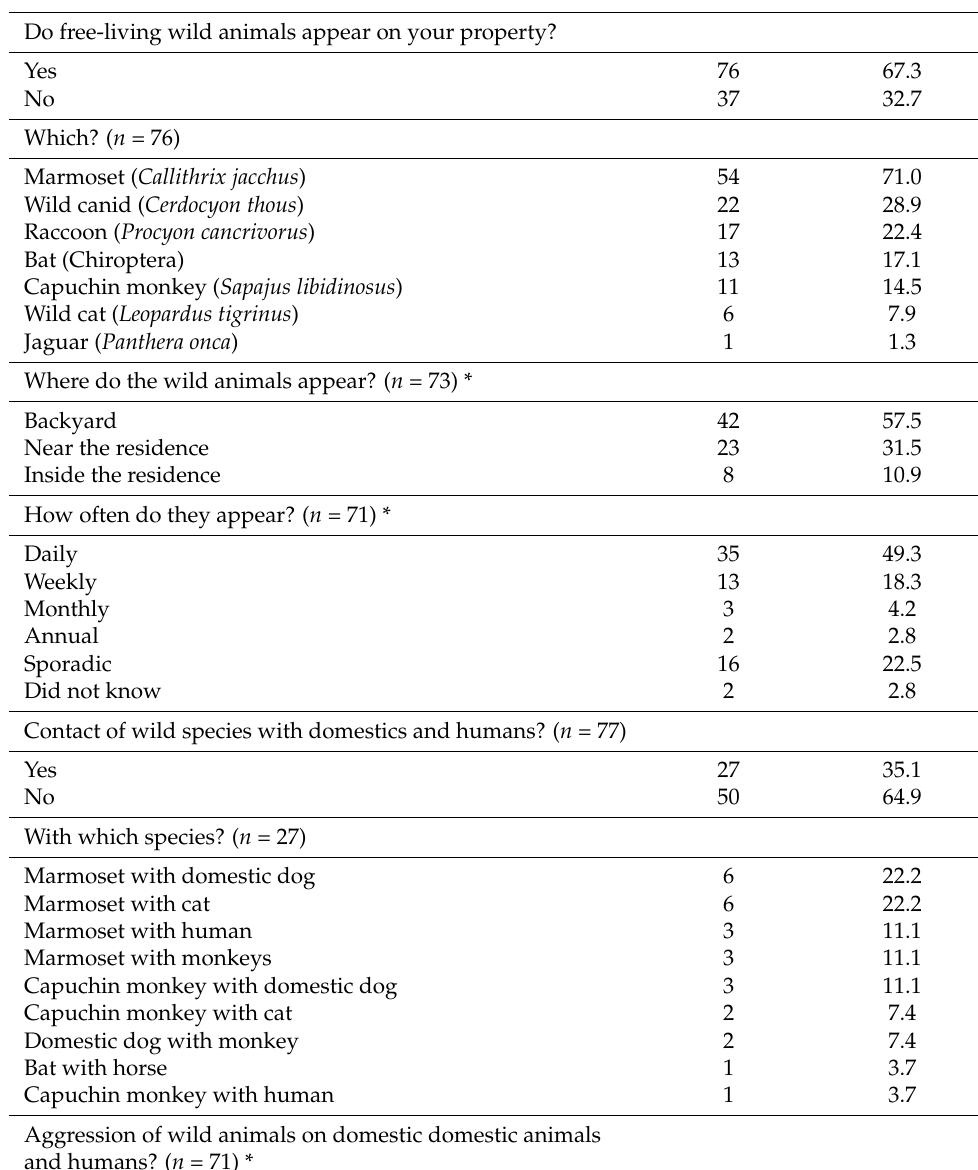
Table 5. Presence of free-living wild animals on respondents’ properties and contacts between wild and domestic animals, Cear á , Brazil, 2019 ( n = 113). Domestic dogs ( Canis familiaris ) include both owned dogs and feral